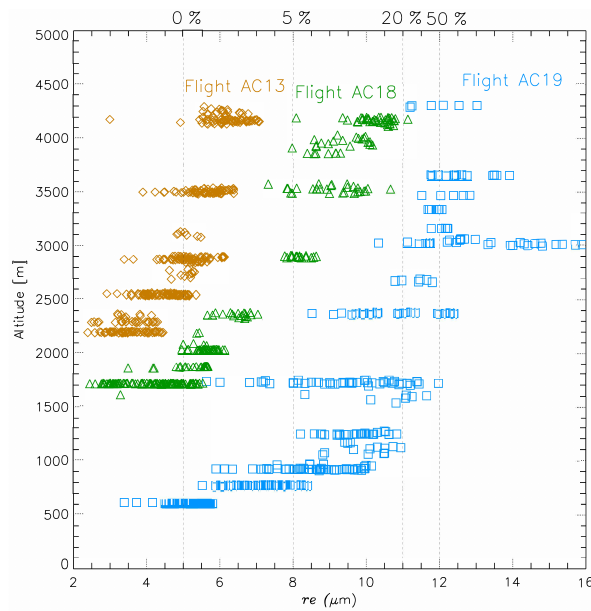
Figure 3. Cloud droplet effective radius ( r e ) as a function of al- titude for clouds over clean (Flight AC19; blue squares), polluted (Flight AC18; green triangles), and very polluted (Flight AC13; brown diamonds) environments. The dashed lines indicate the prob- ability of rain from the coalescence process expressed as a percent- age on the top of the figure.